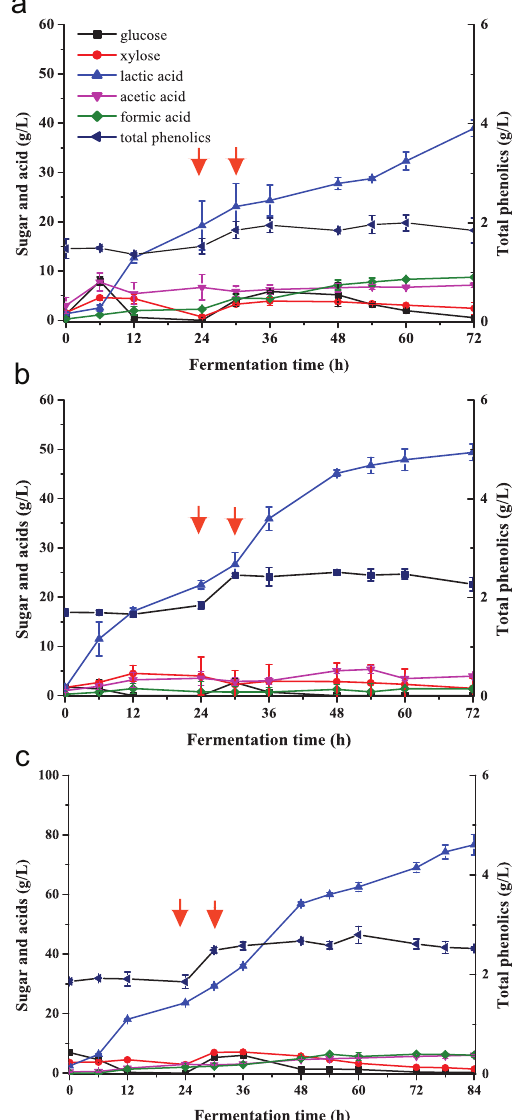
Figure 7. Fed-batch SSF lactic acid fermentation of biodetoxified corn stover at high-solid load using B. coagulans LA204. The initial 8% NH 3 /H 2 O 2 -pretreated and unwashed corn stover was biodetoxifed by K. huakuii LAM0618 T in the bioreactor. After detoxification, B. coagulans LA204 was